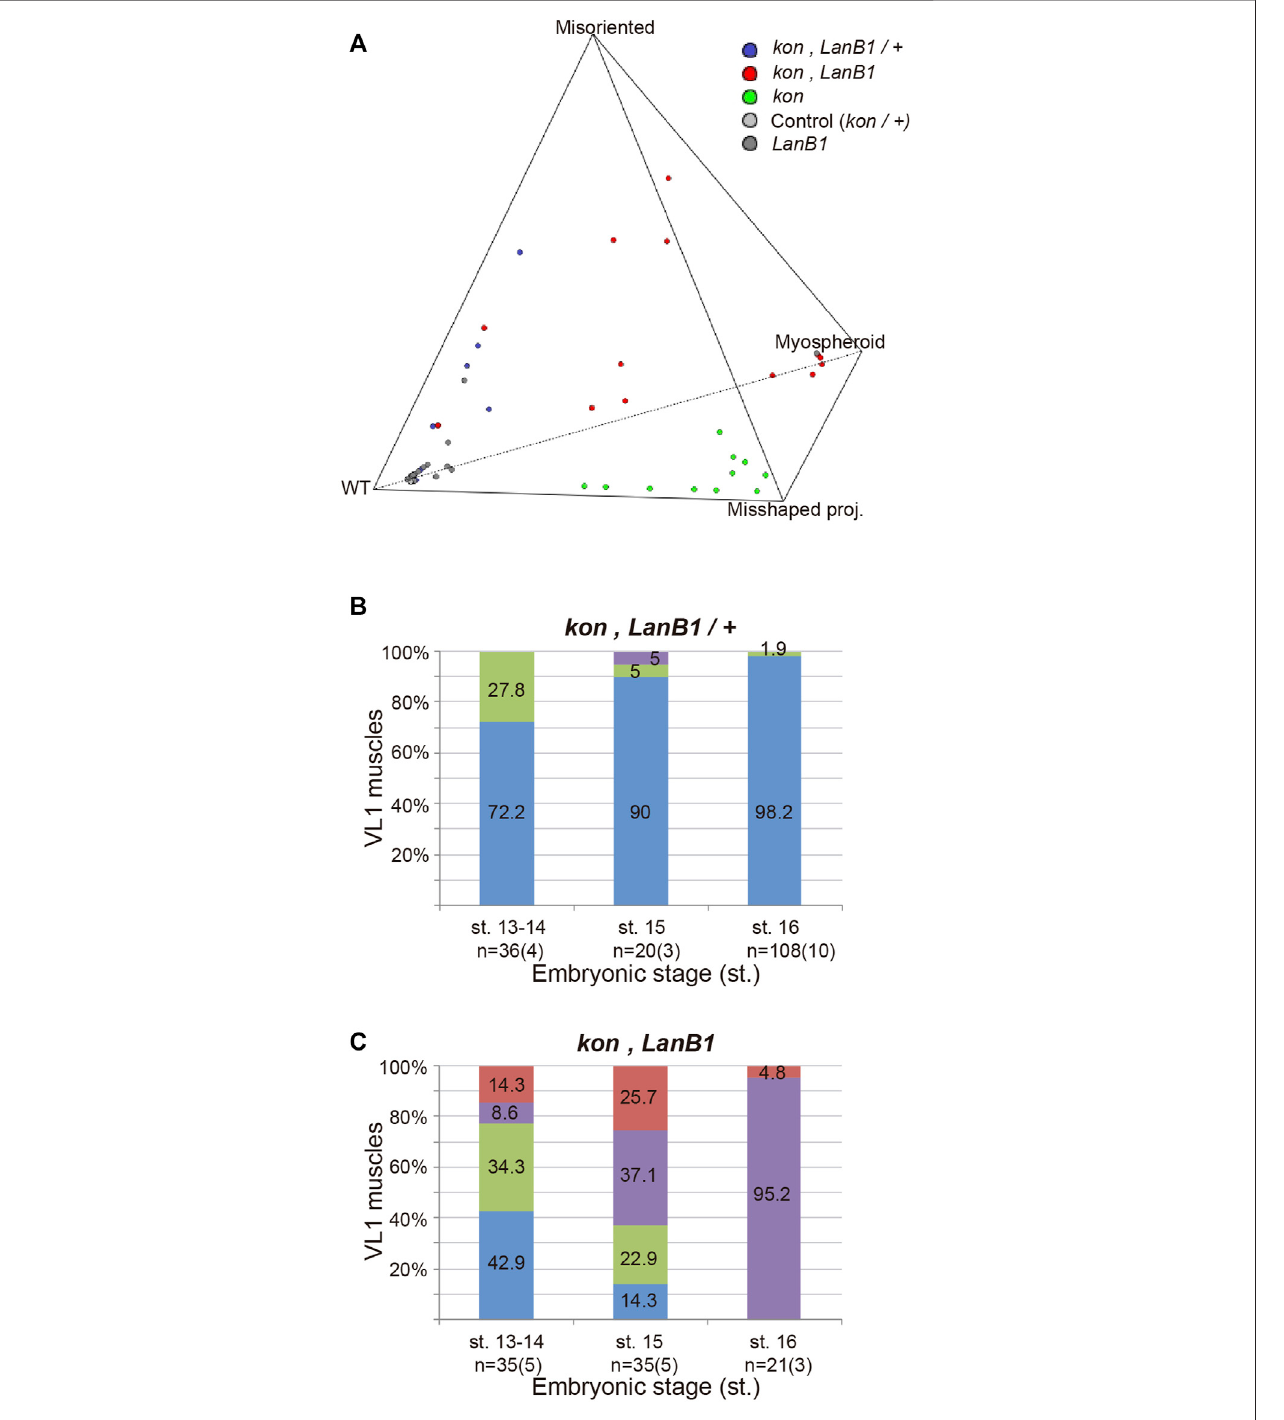
FIGURE 3 | LanB1 and kon interaction during the development of the VL1 muscle. (A) Quaternary plot showing the embryo distribution among genotypes according to the morphology of their muscles. Multivariate analysis of variance (MANOVA) statistical test, p < 0.00001. (B,C) Quanti fi cation of the proportion of VL1 muscles according to their morphology at different embryonic stages for the indicated genotypes. Bar colors indicate VL1 muscle phenotypes: WT, blue; Misoriented, green; Misshaped projection, red; Myospheroid, purple. Representative examples of these phenotypes are shown in Figure 2 . Sample size indicates the total number of muscles over the number of embryos indicated between parentheses. Binomial distribution test was performed for pairwise comparisons: misoriented muscles at st. 13, 14 between LanB1 and kon, LanB1/+ . p (cid:1) 0.046; misoriented muscles at st. 13, 14 between kon, LanB1 and kon, LanB1/+ . p (cid:1) 0.55; total abnormal muscles at st. 13, 14 between kon, LanB1 and kon . p (cid:1) 0.60; total abnormal muscles at st. 15 between kon, LanB1 and kon . p (cid:1) 0.43.